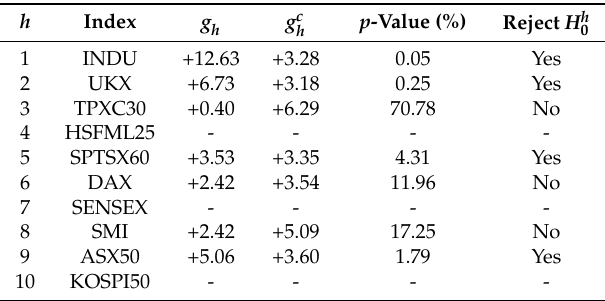
Table 10. Time stability test (95%) for γ ◦